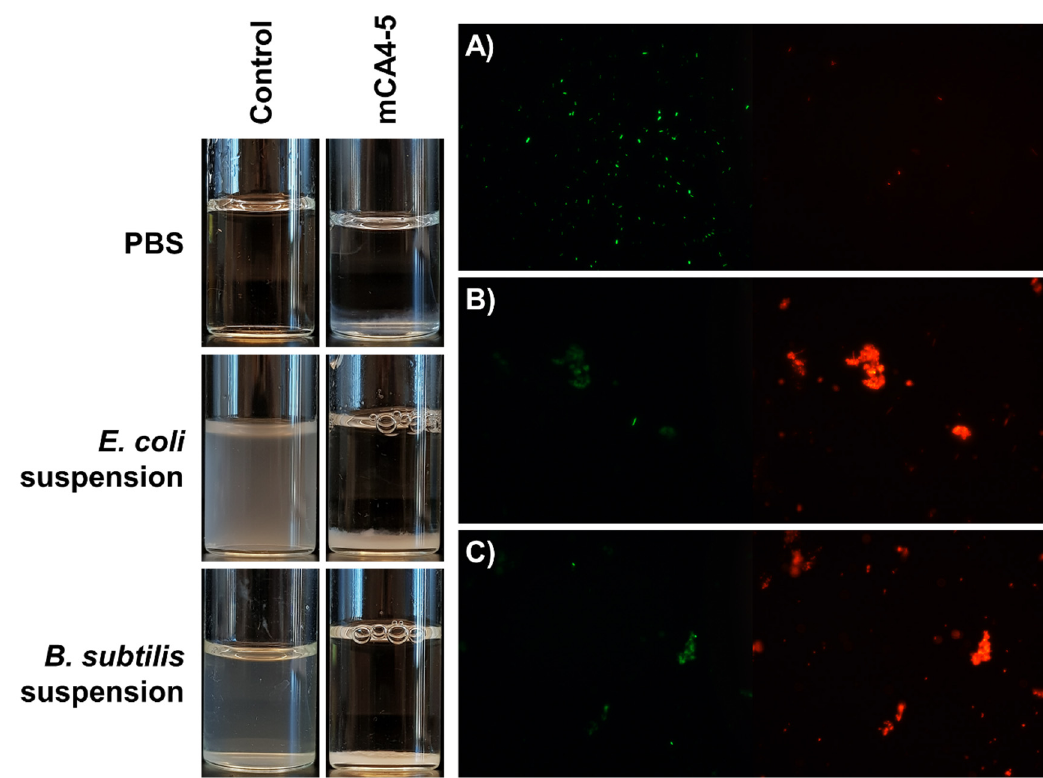
Figure 4. Optical images of PBS solution, E. coli suspension, and B. subtilis suspension in the presence and absence of peptide ( left ) . Fluorescence microscopy images ( right ) of ( A ) PBS-treated E. coli , ( B ) peptide-treated E. coli , and ( C ) peptide-treated B. subtilis.